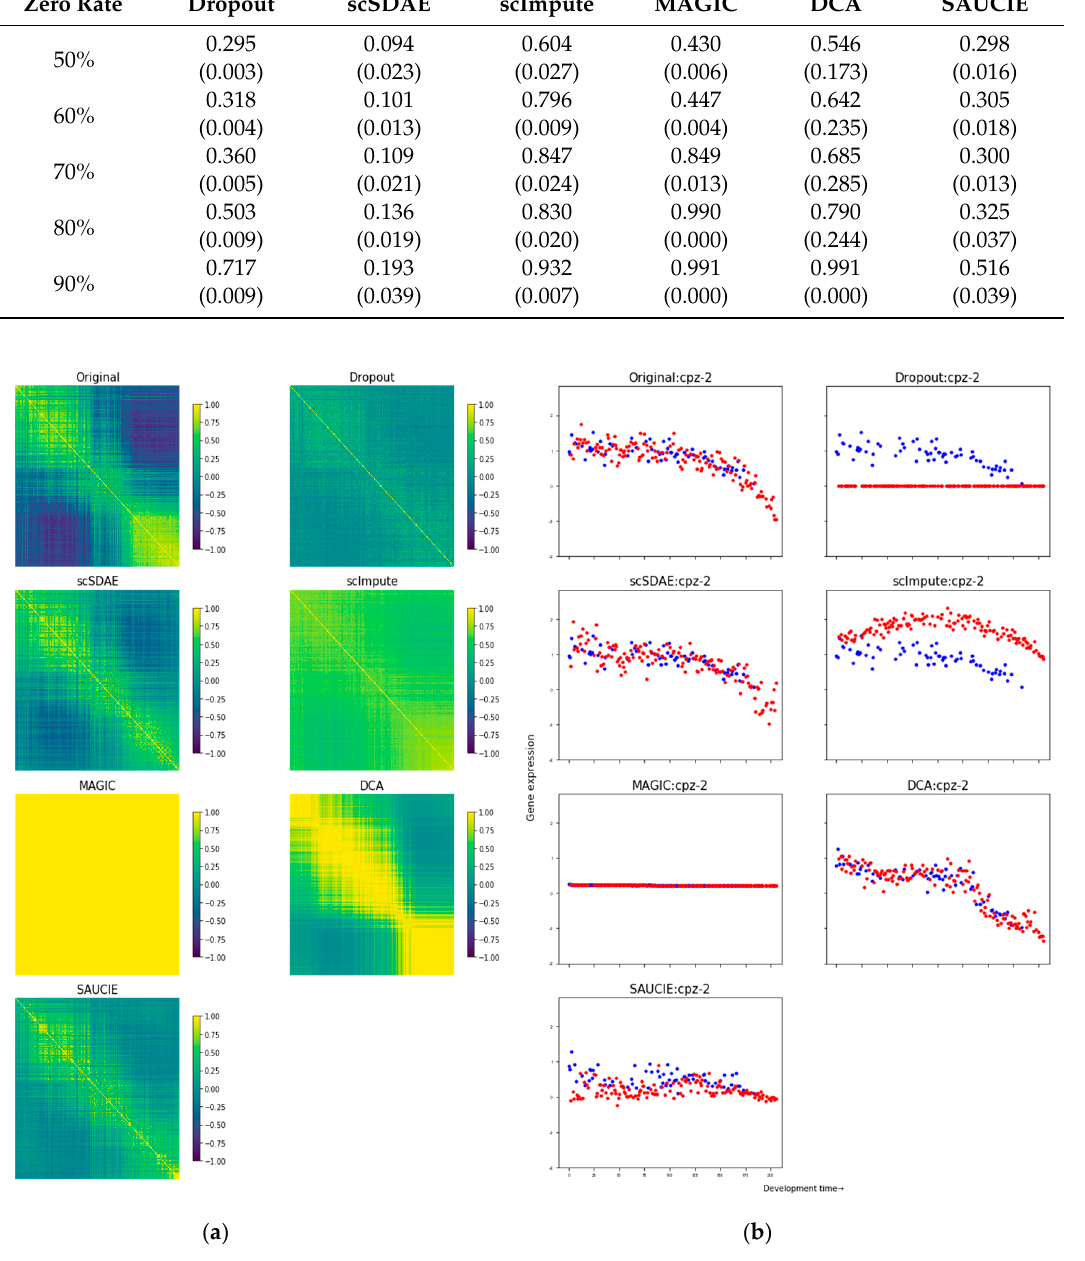
Table 1. The mean and standard deviation of the CMDs between the original and the dropout / imputed matrix.